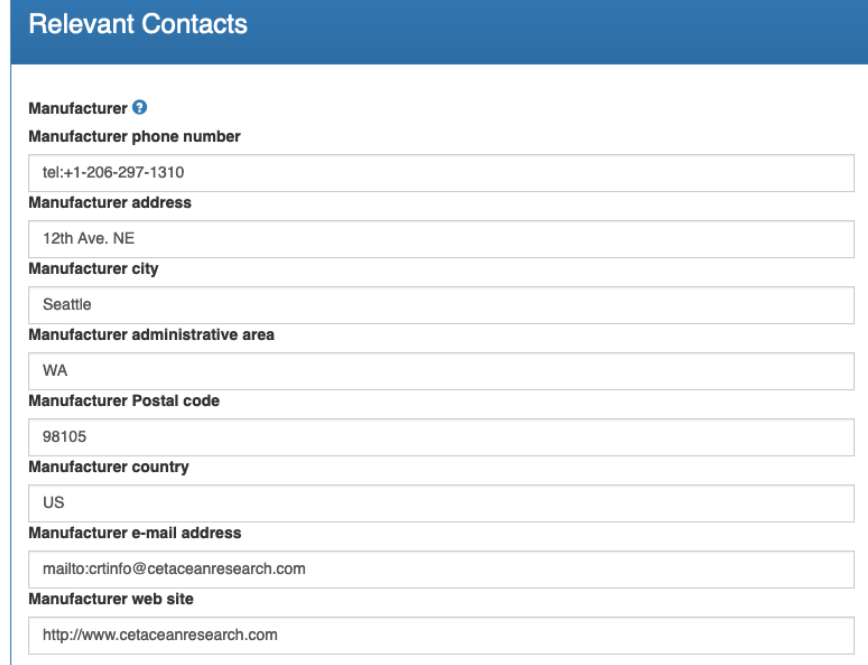
Figure A3. EDI web form rendering of the constraints in Listings A7 and